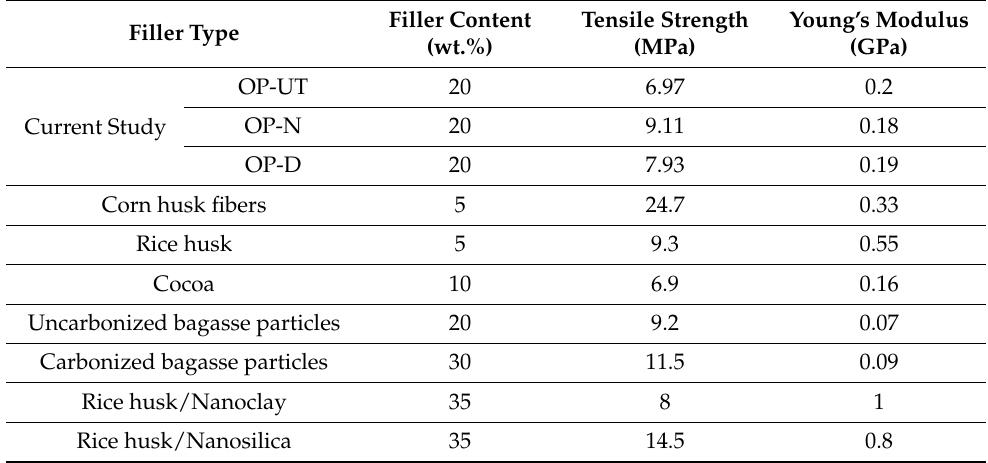
Table 2. Tensile properties of natural-filler-reinforced rLDPE composites reported in the literature [25].